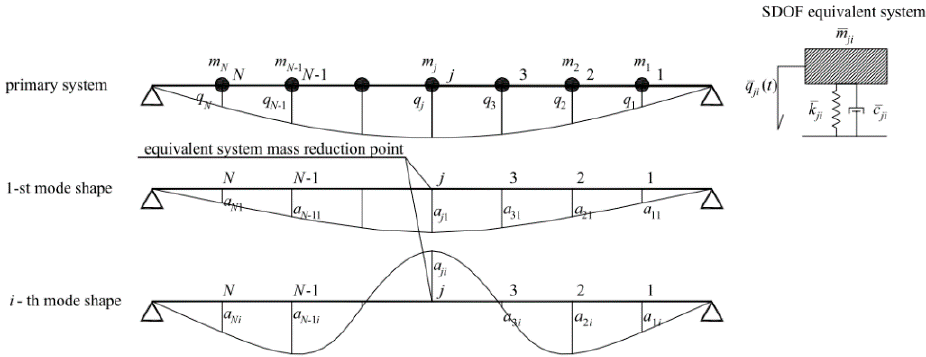
Figure 1. The primary system, adopted first, and i- th mode shape, together with an SDOF equiva- lent system.